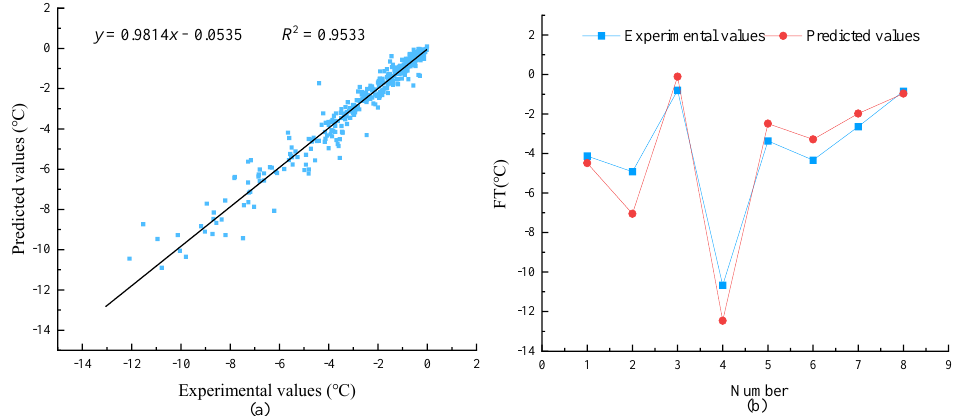
Figure 5. Comparison of predicted and experimental values for the BPNN model: ( a ) training values; ( b ) testing values.